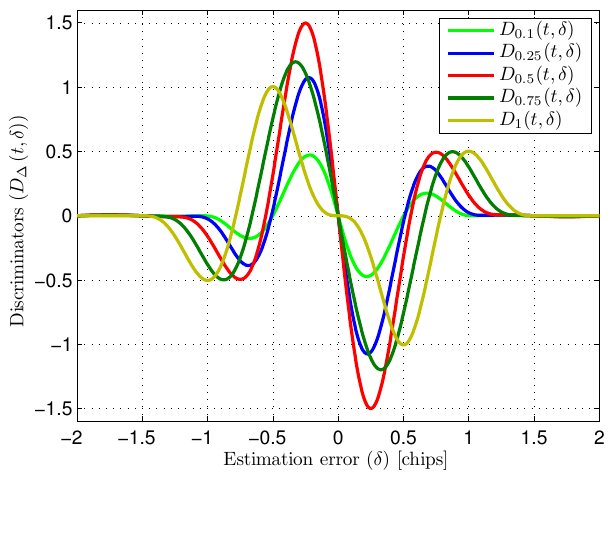
Figure 4. Discriminators D early-late spacing ( ∆